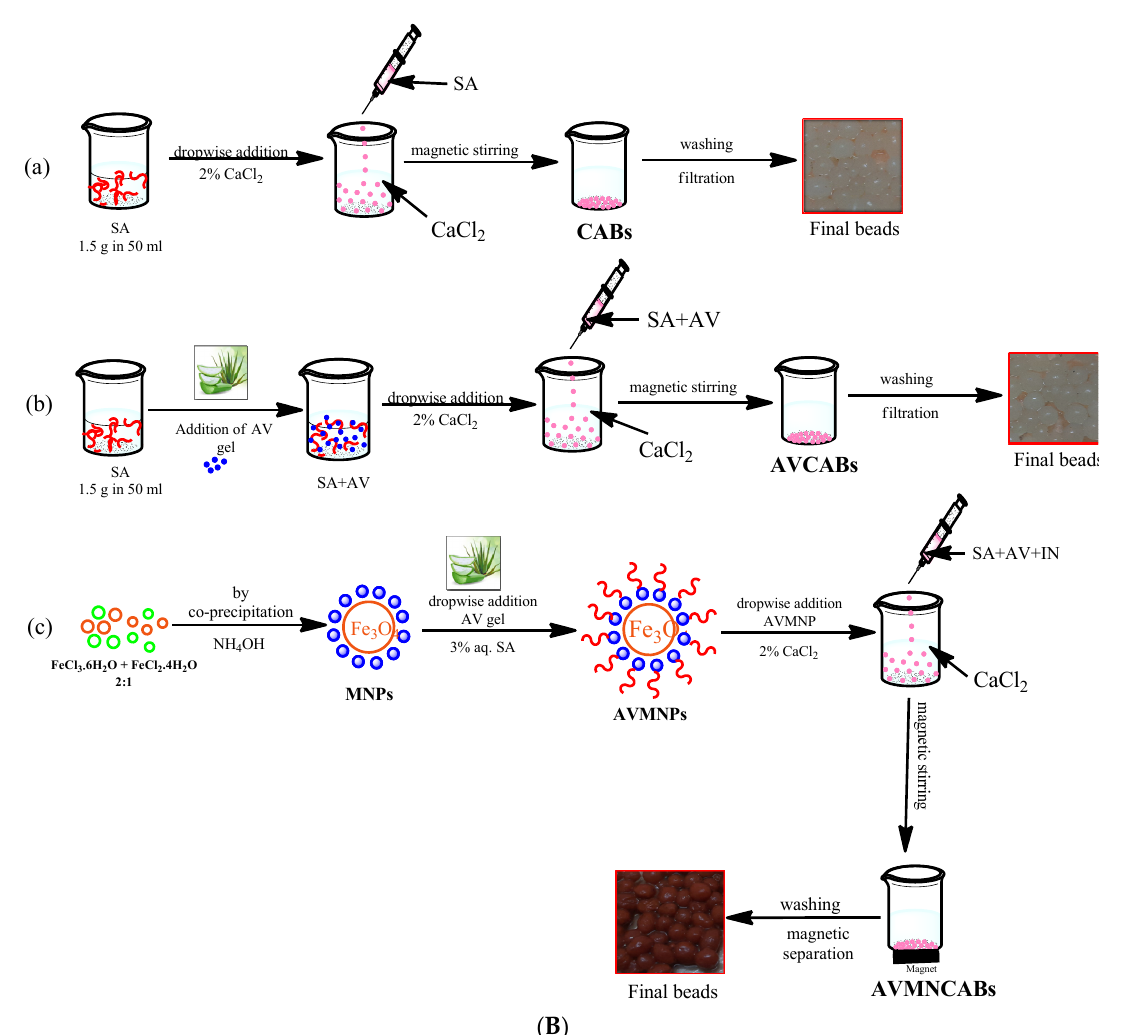
Figure 1. ( A ) Images of the ( a ) CABs , ( b ) AVCABs and ( c ) AVMNCABs gel beads (approximate size of beads: 2–3 mm); ( B ) Synthesis of ( a ) CABs , ( b ) AVCABs , and ( c ) AVMNCABs gel